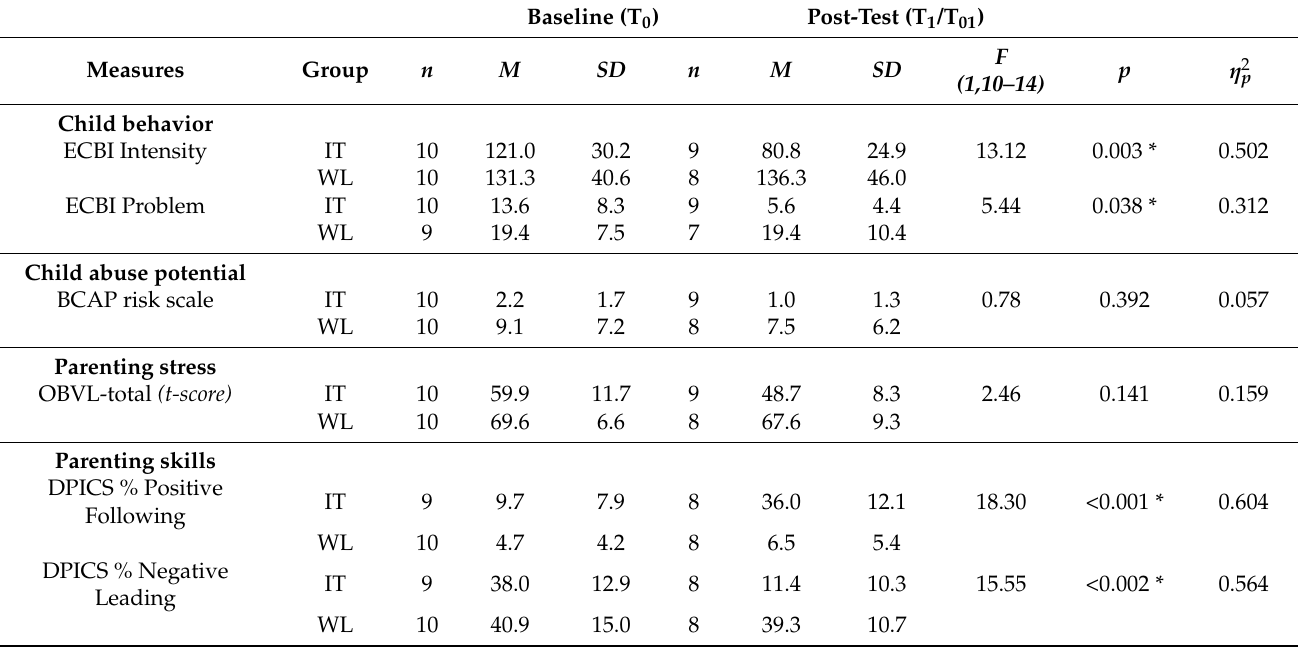
Table 2. Comparisons of change between outcomes at time 1 and time